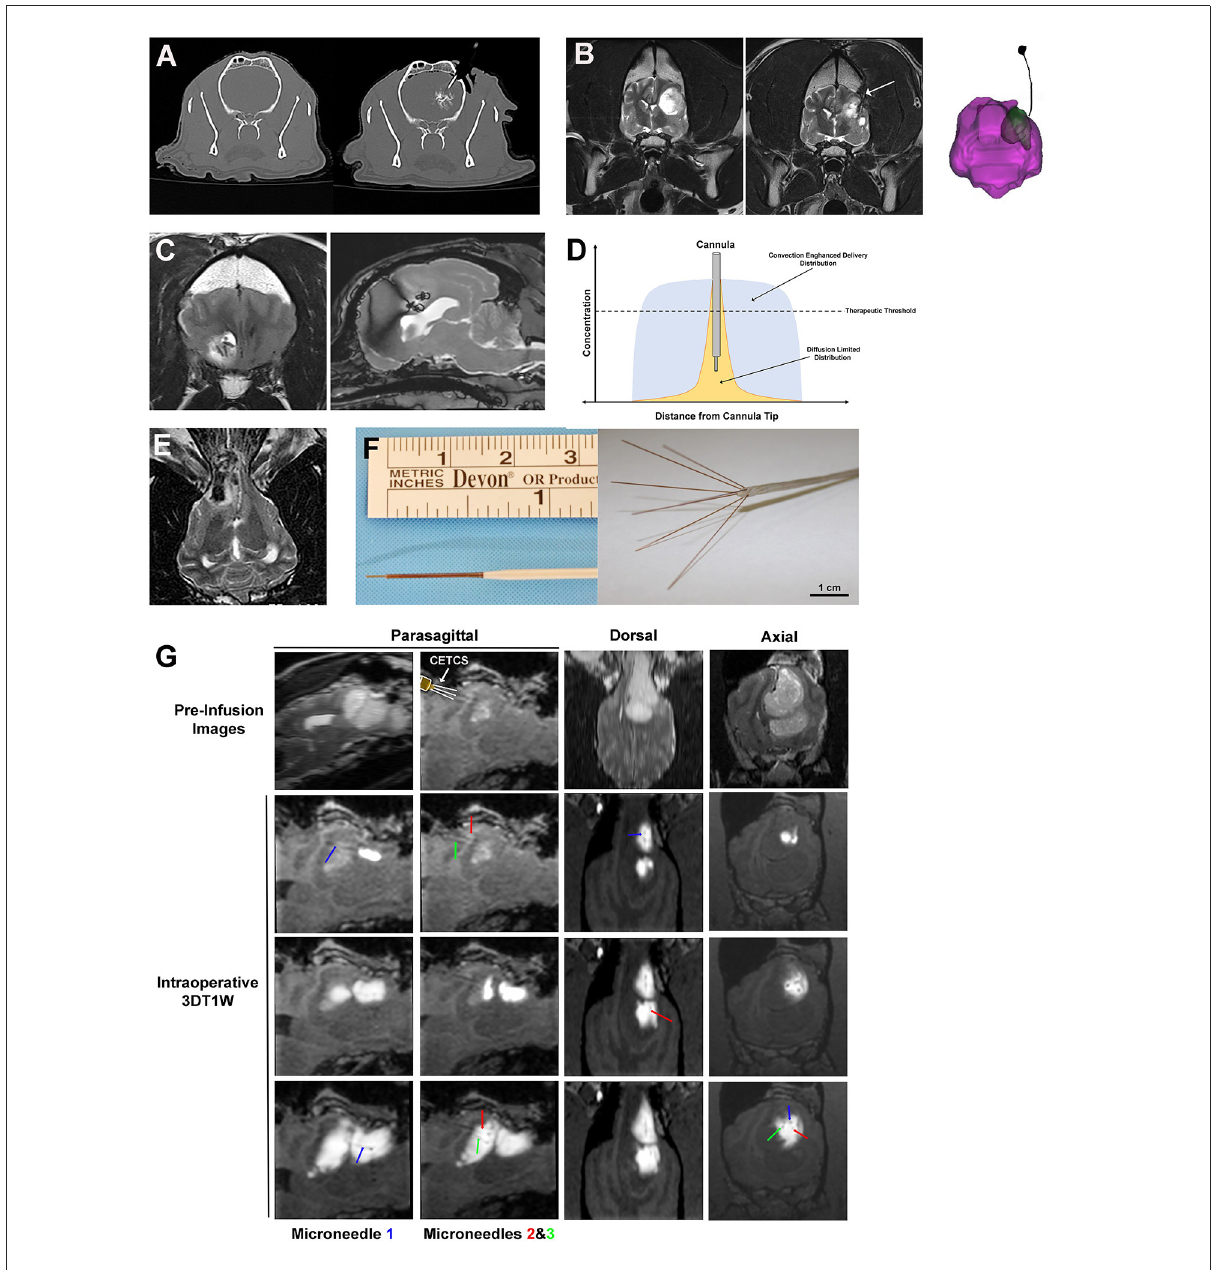
FIGURE5 Interstitial approaches to drug delivery to the canine brain. (A) Interstitial bolus injection of nanoparticle-based temozolomide and iodinated contrast to the caudate nucleus of a dog, with unintended distribution of the infusate outside of the intended target region (right panel). (B) Pre-operative image (left panel) of high grade oligodendroglioma in the left frontoparietal lobes of the cerebrum, with a chronically implanted interstitial catheter for immunotherapy treatment visible in the tumor resection cavity (arrow, middle panel and far right panel). (C) Implanted, biodegradable microcylinders for sustained release chemotherapeutic delivery to a canine intracranial glioma. The microcylinders appear as discrete linear or round hypointensities within the T2W hyperintense tumor mass. (D) Schematic representation of infusate distributions achievable with interstitial delivery via diffusion (yellow) and convection (blue). (E) Iron-oxide nanoparticle CED in a dog with an oligodendroglioma in the fronto-olfactory region, with the infusate distribution appearing as the hypointense area within the T2W hyperintense tumor. (F) CED catheters; left panel demonstrates commercially available reflux preventing catheter with step-down features (ClearPoint Neuro, Solano Beach, CA, United States); right panel illustrates distal end of the CETCS system with microneedles arborized from the primary cannula. (G) MRI-guided CED infusion of a canine glioma with the CETCS. Individually deployed microneedles (blue, green, and red arrows can be visualized as thin, linear hypointensities extending from the primary cannula. The therapeutic was co-delivered with gadolinium-albumin, such that the infusate spatial distribution can be tracked in real time on the 3DT1W